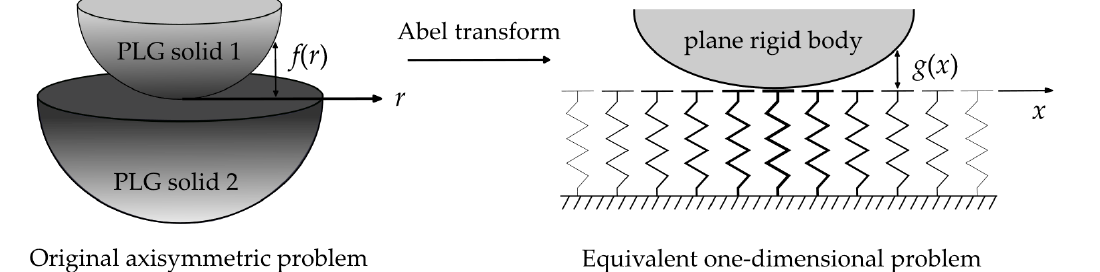
Figure 2. Undeformed contact geometry (initial point contact): ( a ) 3D axisymmetric configuration for two power-law graded elastic solids with the initial gap function f ( r ) ; ( b ) 1D configuration of the equivalent contact in the Abel-transformed domain consisting of a plane rigid indenter with profile g ( x ) and a series of independent linear elastic